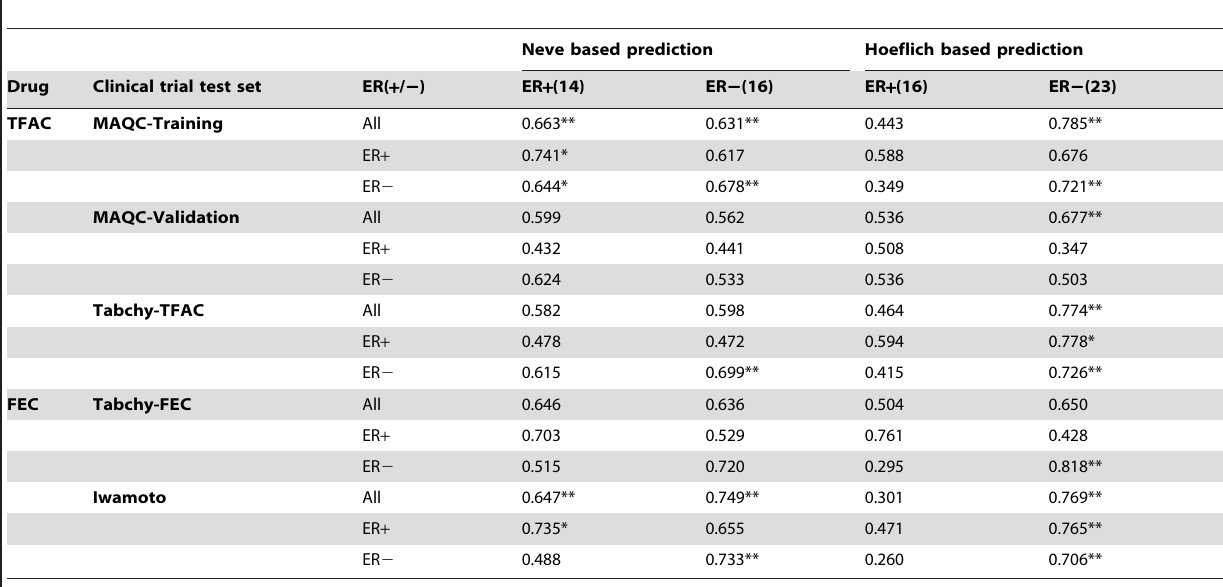
Table 4. Prediction results for the COXEN model using either ER + (ER-positive) or ER– (ER-negative) breast cancer cell lines, evaluated by area under receiver operator characteristic (AU-ROC)